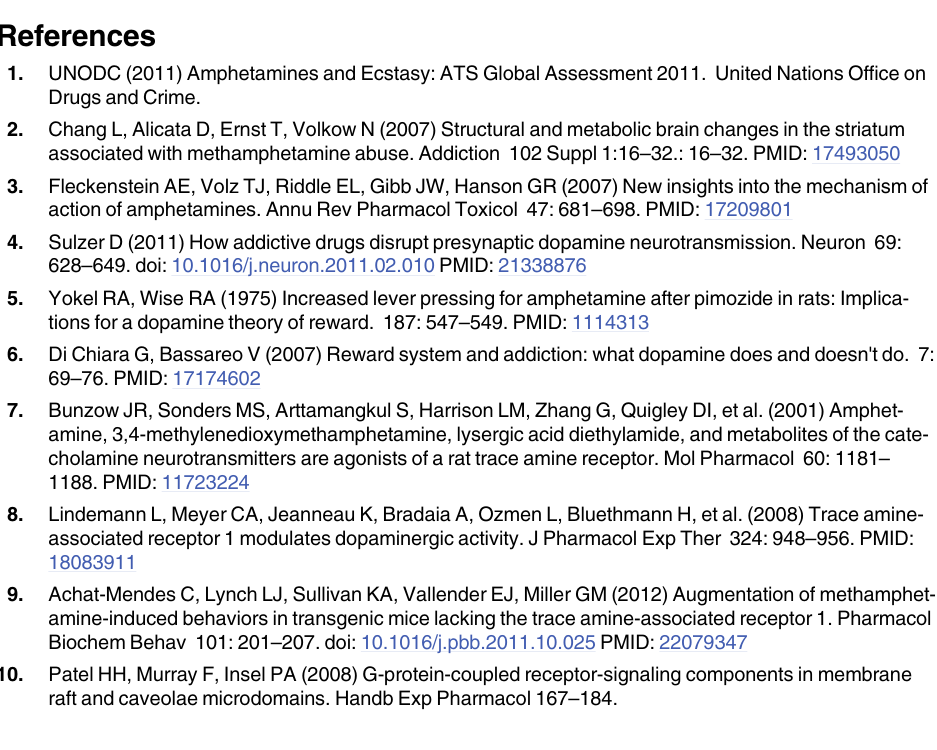
S1 Table. Detailed Proteomic